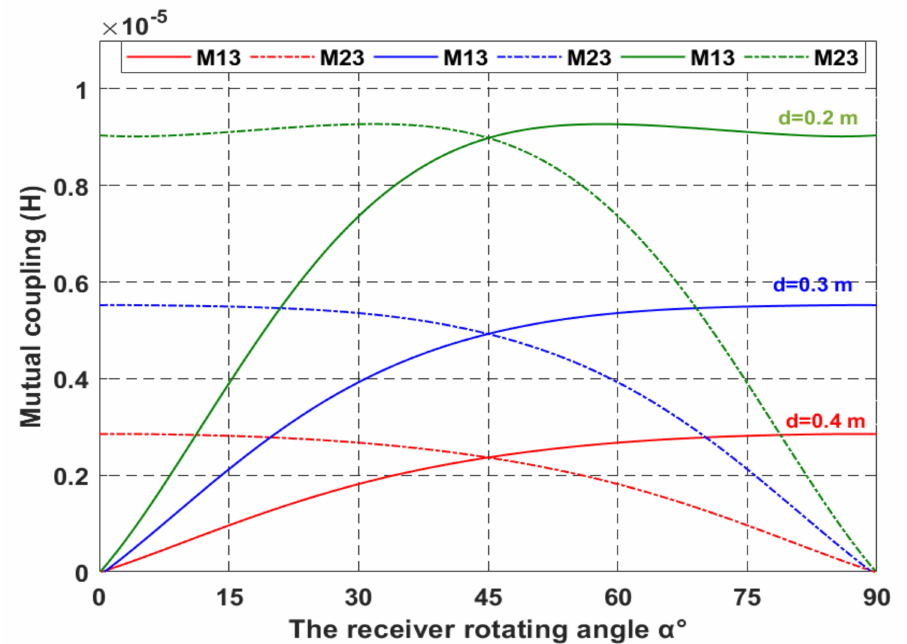
Figure 14. Mutual coupling curves in terms of α for different values of